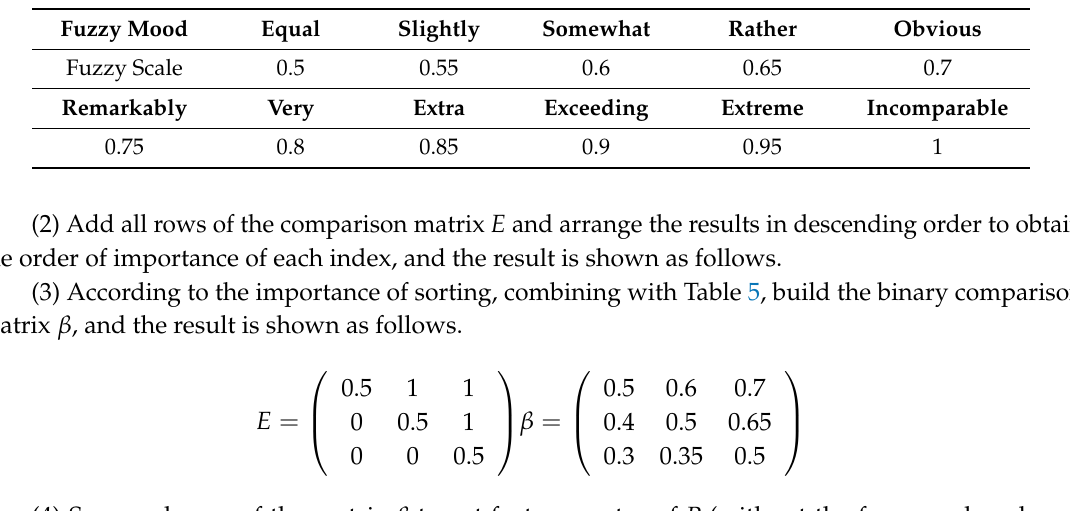
Table 5. Relationship tables of fuzzy mood operators and the fuzzy